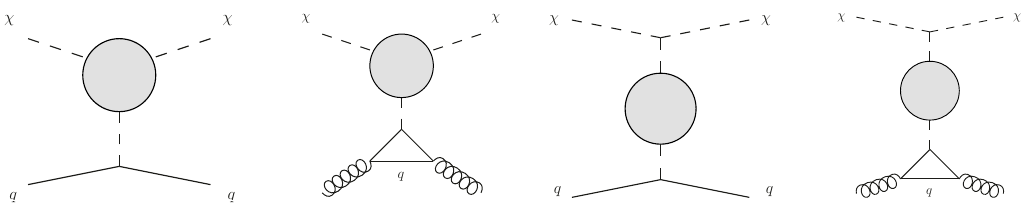
Figure 1 . Schematic diagrams with upper vertex corrections and propagator